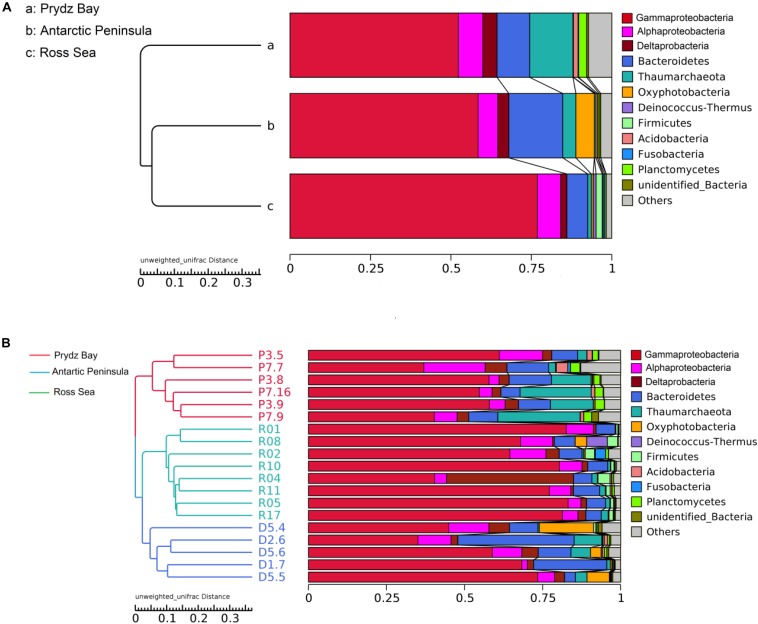
Clustering of surface sediment prokaryotic communities of three regions (A) and of each sample (B) by Unweighted Pair-group Method with Arithmetic Mean.